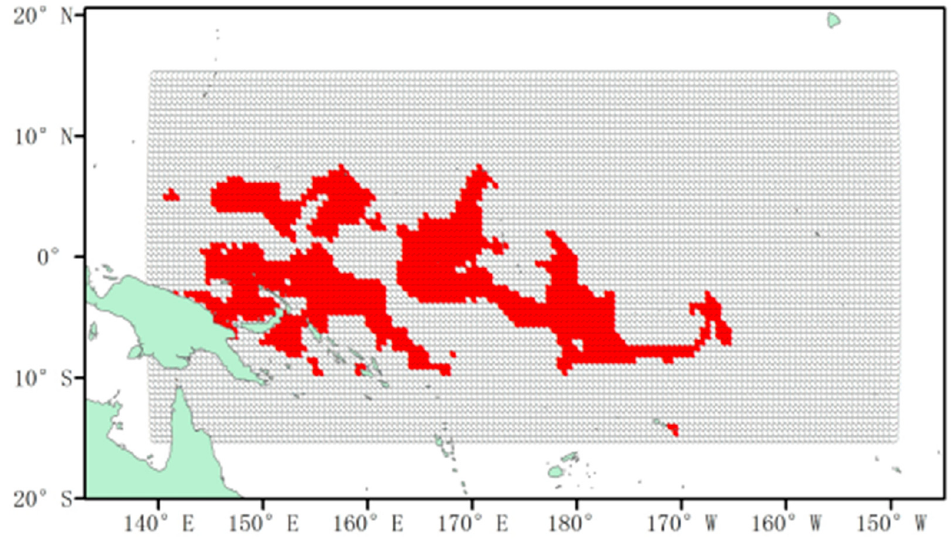
Figure 8. Hot spots analysis of fishing effort invested by vessels at high-speed transiting (Hot spots = red areas; based on 0.5° × 0.5° grids).